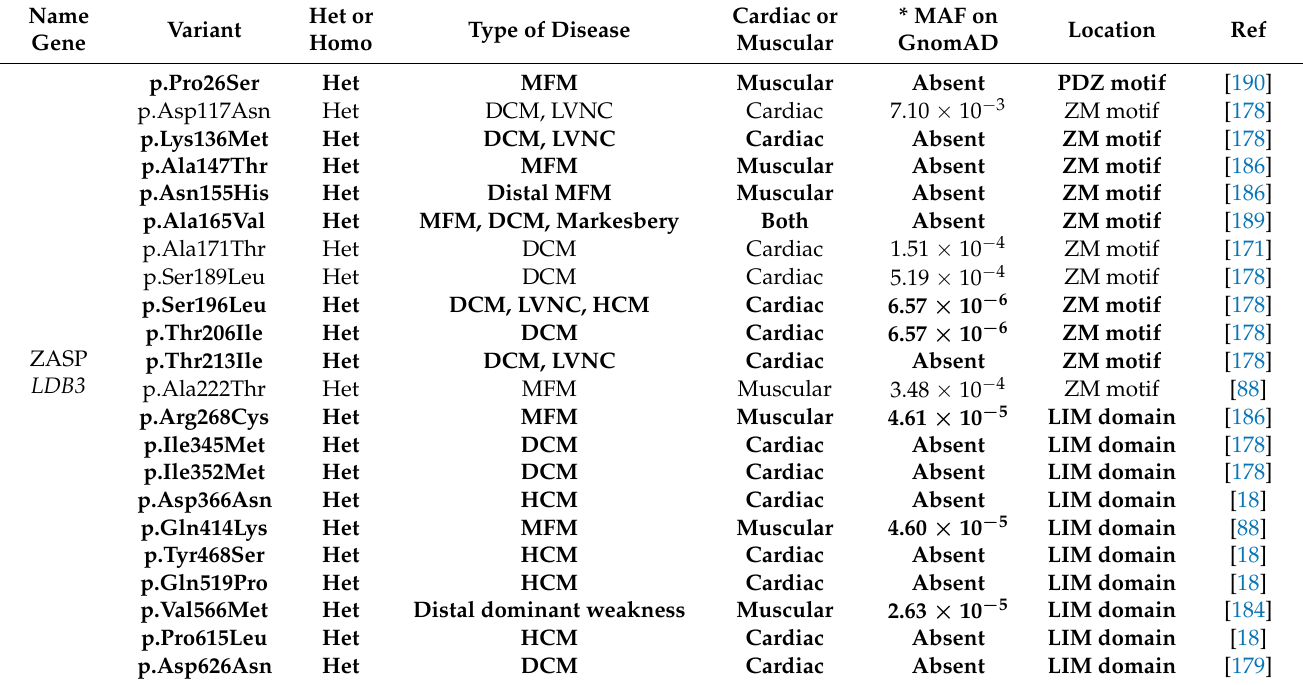
Table 6. Variants in the LDB3 gene that have been previously reported in individuals with myopathy or cardiomyopathy.